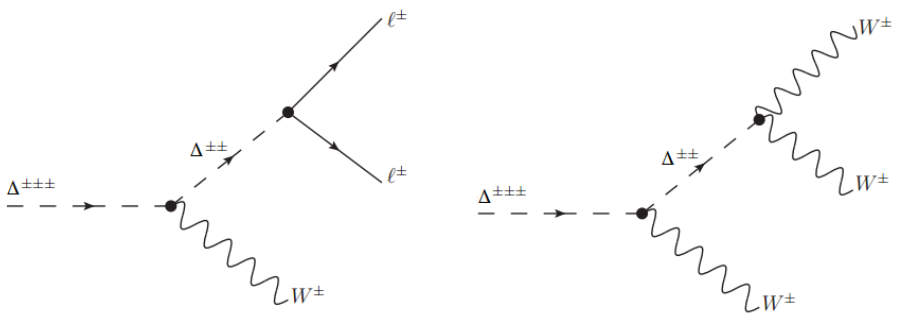
Figure 9 . Feynman diagrams for decay of triply charged scalar (cid:1) (cid:6)(cid:6)(cid:6)